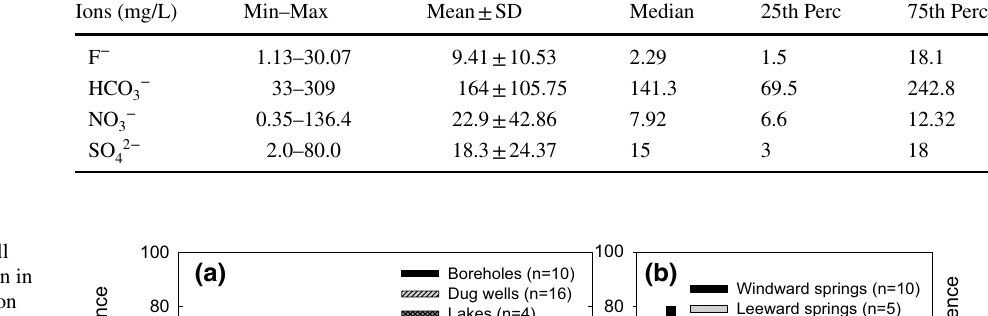
Fig. 5 a pH distribution in all water types, b pH distribution in springs based on their position with respect to Mt. Meru